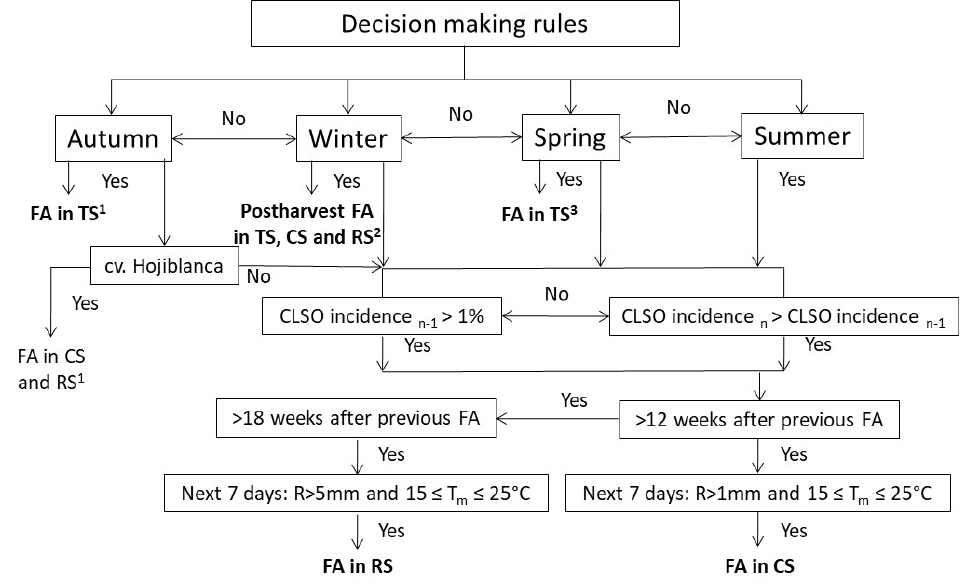
Figure 2. Decision making rules for fungicide application (FA) of traditional, conservative and risky strategies (TS, CS and RS, respectively). 1 Autumn applications in TS or CS / RS in cv.